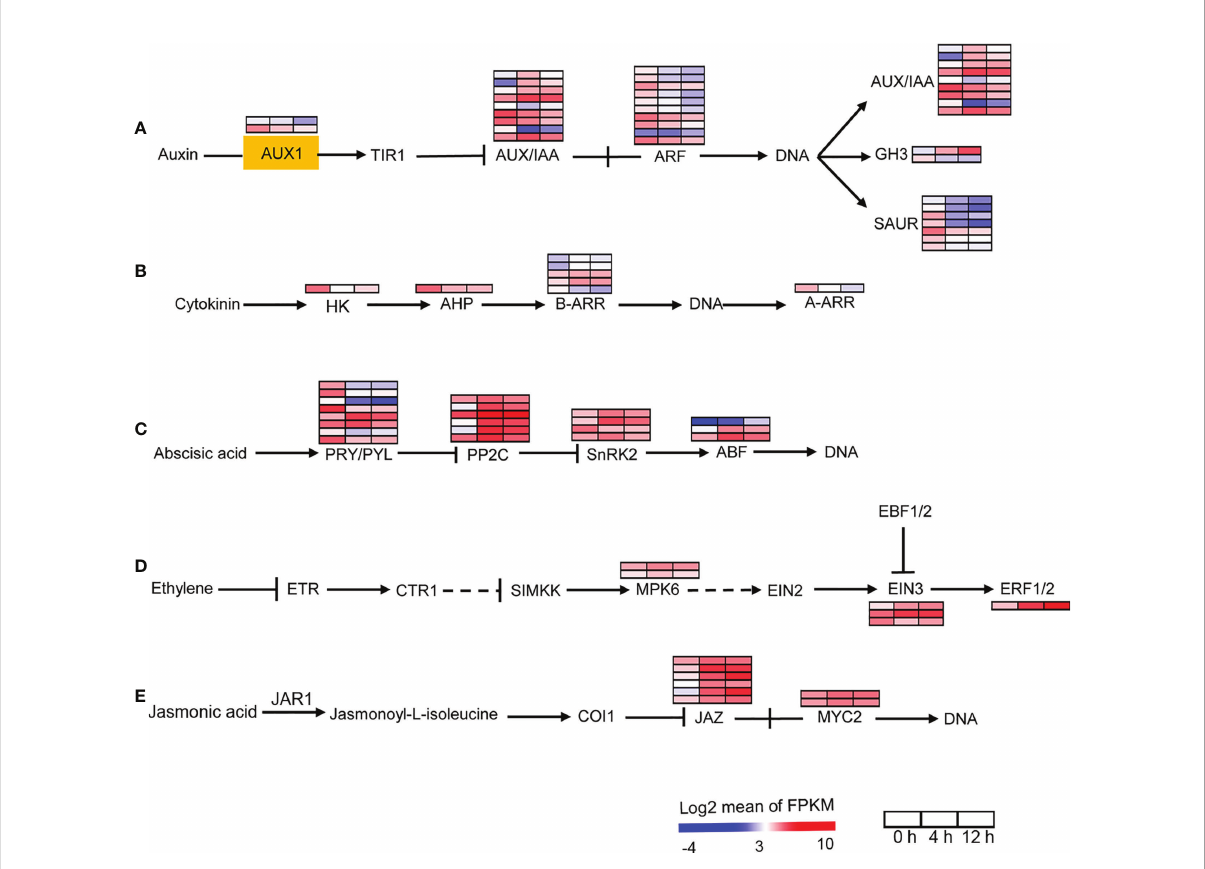
FIGURE 4 Changes in the expression of plant hormone signal transduction pathway under salt treatment. (A) Expression analysis of auxin signal transduction pathway genes. AUX1, auxin in fl ux carrier 1; TIR1, transport inhibitor response 1; Aux/IAA, auxin/indole acetic acid protein; ARF, auxin response factor; GH3, Gretchen Hagen; SAUR, small auxin-up RNAs. (B) Expression analysis of cytokinin signal transduction pathway genes. HK, histidine kinase; AHP, histidine-containing phosphotransfer protein; A-ARR, type ‐ A Arabidopsis response regulator; B-ARR, type ‐ B Arabidopsis response regulator. (C) Expression analysis of ABA signal transduction pathway genes. PRY/PRL, abscisic acid receptor PYR/PYL family; PPC2C, protein phosphatase-2C; SnRK2, SNF1 ‐ related protein kinase 2, ABF, ABA responsive element binding factor. (D) Expression analysis of ethylene signal transduction pathway genes. ETR, ethylene receptor; CTR1, serine/threonine-protein kinase 1; SIMKK, mitogen- activated protein kinase kinase; MPK6, mitogen-activated protein kinase 6; EIN2/3, ethylene-insensitive protein 2/3; EBF1/2, EIN3 ‐ binding F ‐ box protein 1/2; ERF1/2, ethylene-responsive transcription factor 1/2. (E) Expression analysis of JA signal transduction pathway genes. JAR1, jasmonic acid-amino synthetase; COI1, coronatine-insensitive protein 1, MYC2, transcription factor MYC2. The pathways were redraw based on ‘ Plant hormone signal transduction ’ in the KEGG database (https://www.kegg.jp/). Genes that changed signi fi cantly in at least one time point after salt treatment are